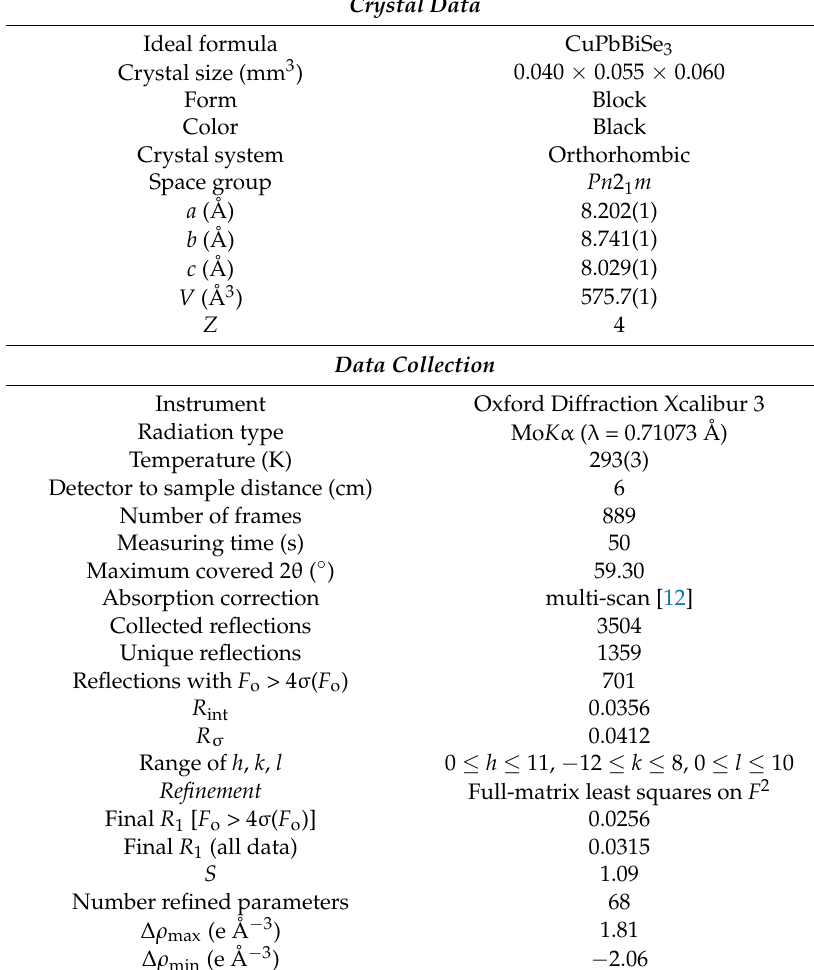
Table 5. Data and experimental details for the selected cerromojonite